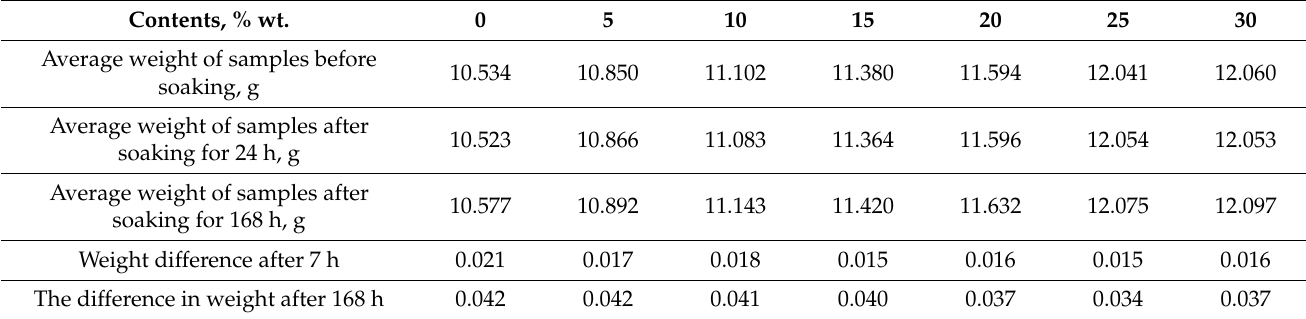
Table 9. Absorbability of PLA filled with micronized chalcedonite Crusil